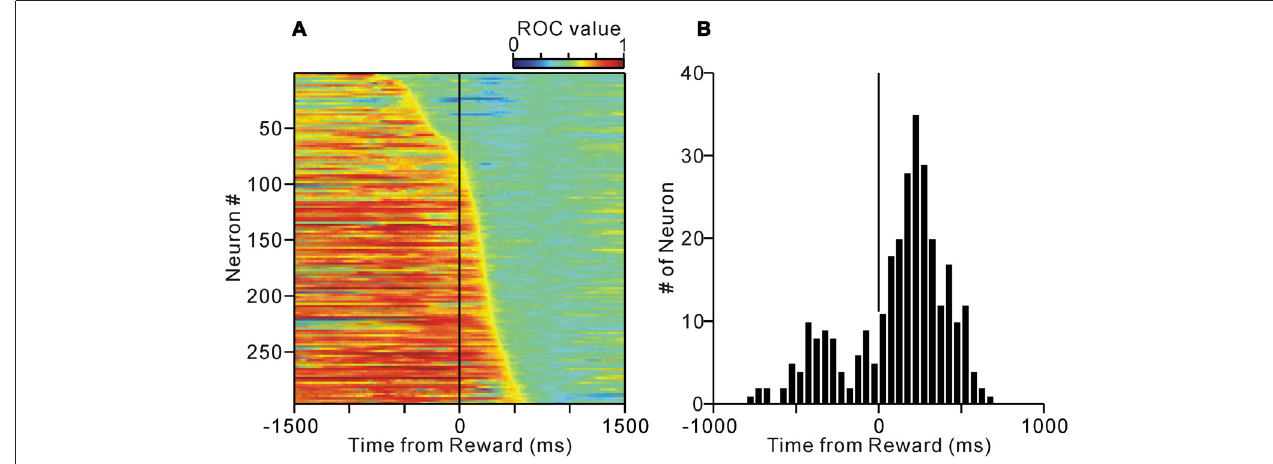
FIGURE 2 | (A) Activity of the tonic excitatory neurons of the PPTg during the normal saccade task. The activity of each of the 296 PPTg neuron is presented as a row of pixels. The data are aligned to the time of reward delivery. The neurons were sorted in the order of their termination of tonic firing. The color of each pixel indicates the receiver operating characteristic (ROC) value based on a comparison of the firing rate during a post-reward period (500–1000 ms after the reward delivery) and a test window centered on the pixel (200-ms duration). The warm colors (ROC value > 0.5) indicate higher firing rate relative to the post-reward period, whereas the cool colors (ROC value < 0.5) indicate lower firing rate. (B) Histograms for the termination of tonic activity.